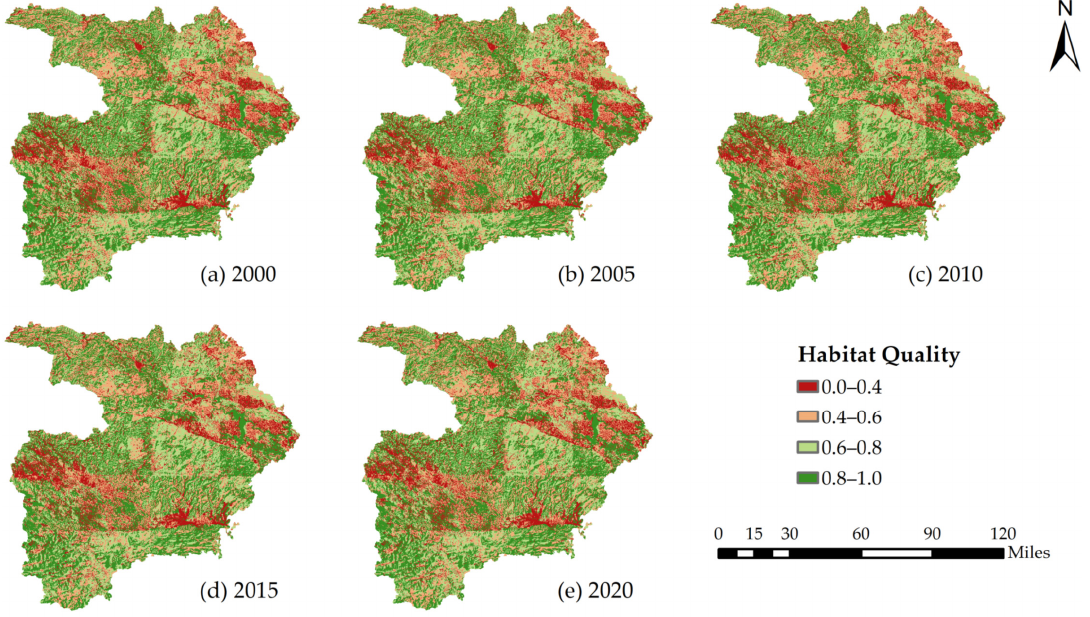
Figure 5. Spatial distribution of habitat quality in Shiyan from 2000 to 2020: ( a ) 2000, ( b ) 2005, ( c ) 2010, ( d ) 2015, and ( e )